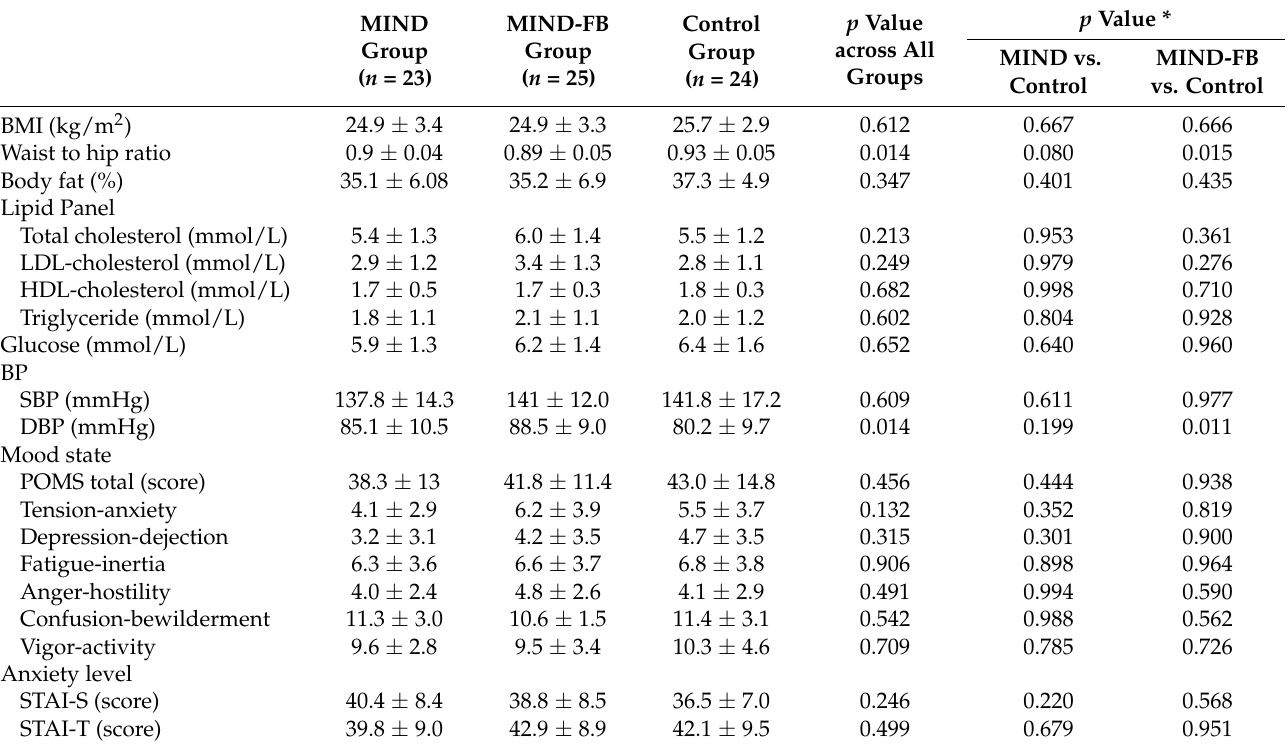
p Value across All Groups